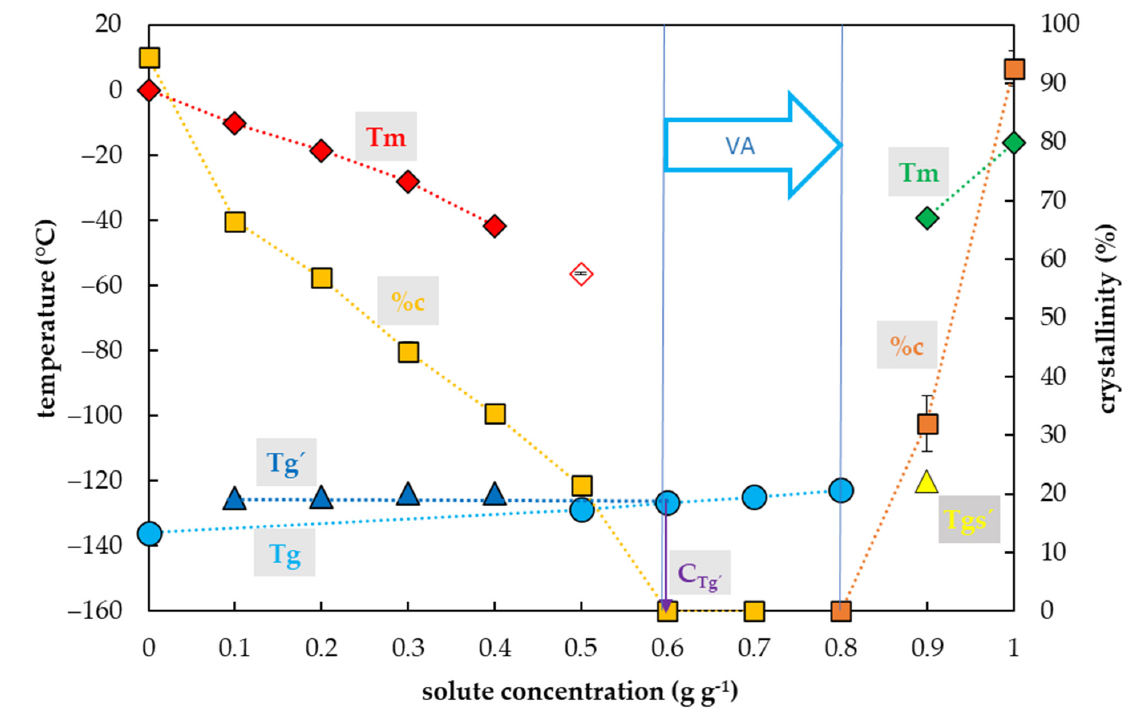
Figure 3. Thermal characteristics of ethylene glycol (EG) depending on its concentration in an aqueous solution. The total concentration of solutes is expressed as the mass of solutes (g) per mass of aqueous solution (g). The left y -axis indicates the temperature of the thermal events, the right y -axis shows the percentage of crystallinity of water or EG based on the total mass of the solution. The temperature of the glass transition (Tg) of the solution is indicated by a cyan circle, the Tg’ originating from the freeze-concentrated solution during the cooling period is indicated by a blue triangle, the Tgs´ originating from the EG crystallization is indicated by a yellow triangle, the onset of water melting peaks (Tm) is marked by a red diamond if the effect occurs during the cooling period and indicated by a hollow diamond if the effect occurs during the warming period. The onset of the EG melting peaks (Tm) is indicated by a green diamond. The percentage of crystallinity of the solvent or solute (%c) based on the total mass of the solution is indicated by an orange square for water and a brown square for EG. The vitrification ability (VA) demonstrates the range of solute concentrations with the appropriate vitrification ability. Cg´ indicates a concentration of the freeze-concentrated solution. All effects were measured during the warming period of C/W cycles at a rate of 10 °C min − 1 . Results are presented as a mean of three repetitions and vertical bars represent standard error.